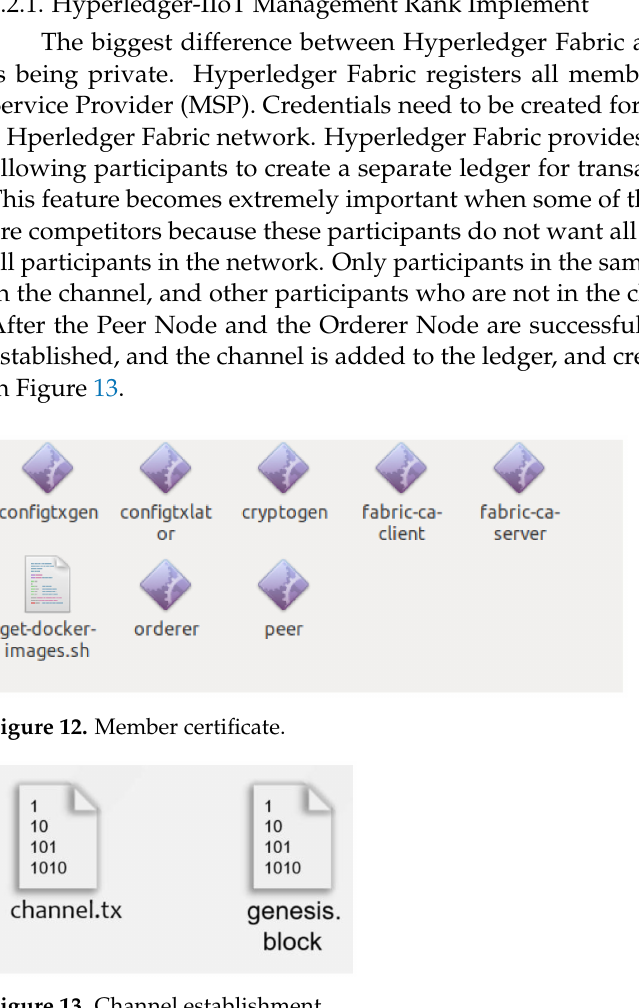
Figure 13. Channel establishment.